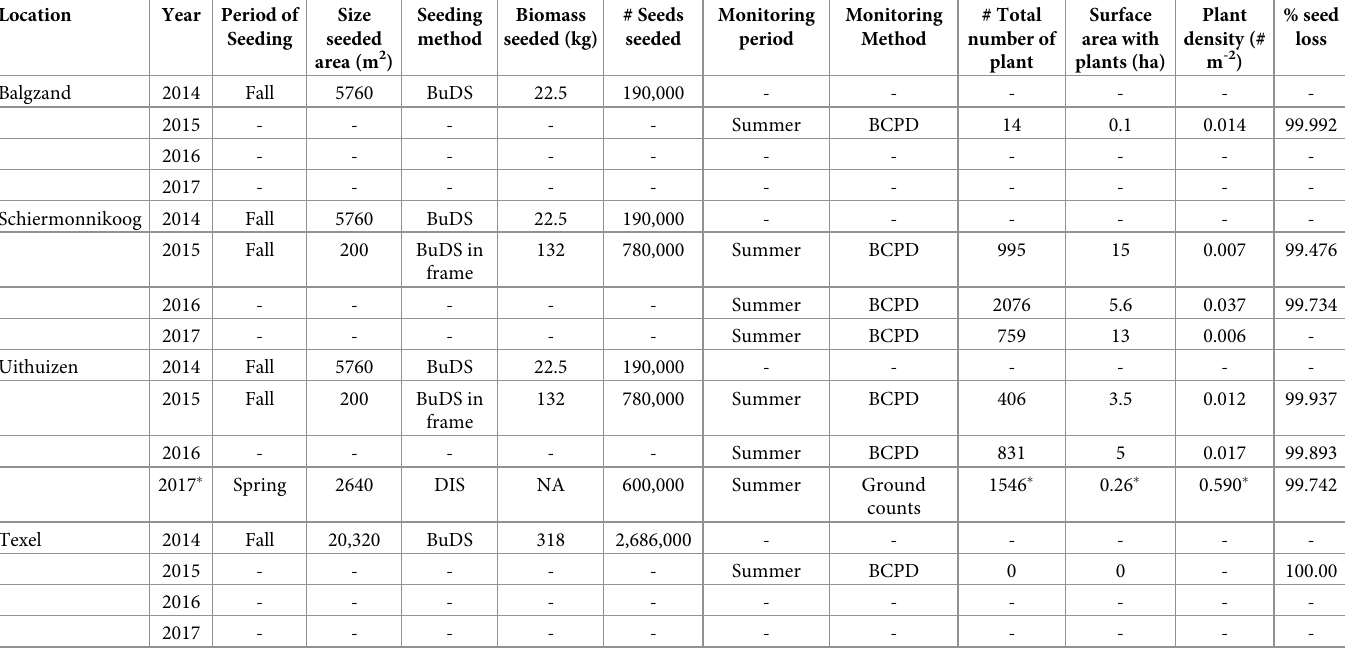
Table 1. Overview of restoration activities in four subsequent years (2014–2017) on five sites in the Dutch Wadden Sea. Location Year Period of